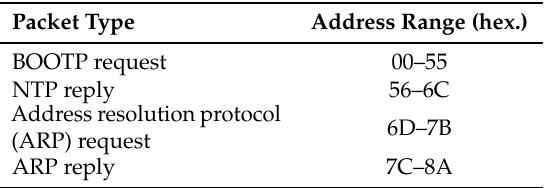
Table 4. Packet RAM memory